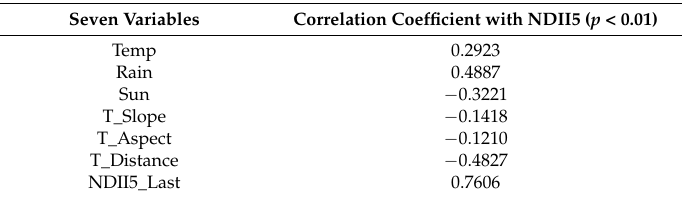
Table 4. The correlation coefficients of seven independent variables with the